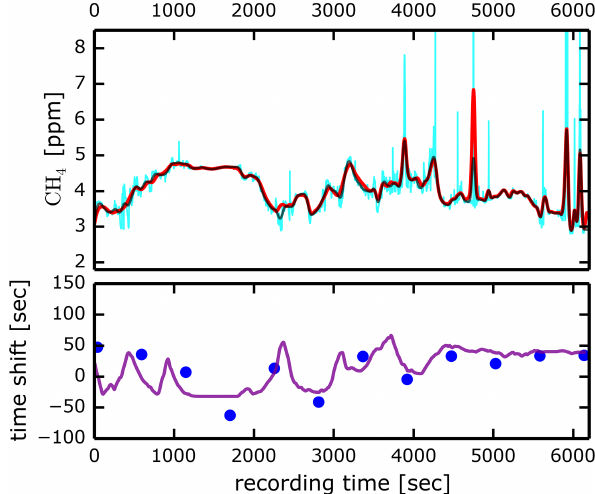
Figure 14. Top panel: cyan denotes the methane signal recorded in the vehicle over about 1.6h on 3 February 2013. Some indi- vidual plumes are as large as 30ppm. Black denotes the methane signal recorded in the vehicle, after applying the smoothing func- tion derived from gas diffusion in the storage tube. Red denotes the methane signal obtained during reanalysis of the gas stored in the tube over about 24h of analysis time. The time axis of the reana- lyzed signal has been adjusted according to the ratio of the flows during recording and reanalysis. To account for flow differences in different parts of the drive, the replay time axis is compressed or expanded using a cubic spline function with 15 knots across the time axis (every 300s), optimizing the time mismatch between the recorded methane signal and the reanalyzed signal. These time shifts are shown in the bottom panel (blue points) (where a posi- tive value indicates that the reanalysis time should be shifted later, indicative of a reduced flow into the tube). The purple line in the bottom panel is the time shift predicted by the inlet flow model for this drive described in the Supplement – the only free parameter was an overall offset to the modeled time